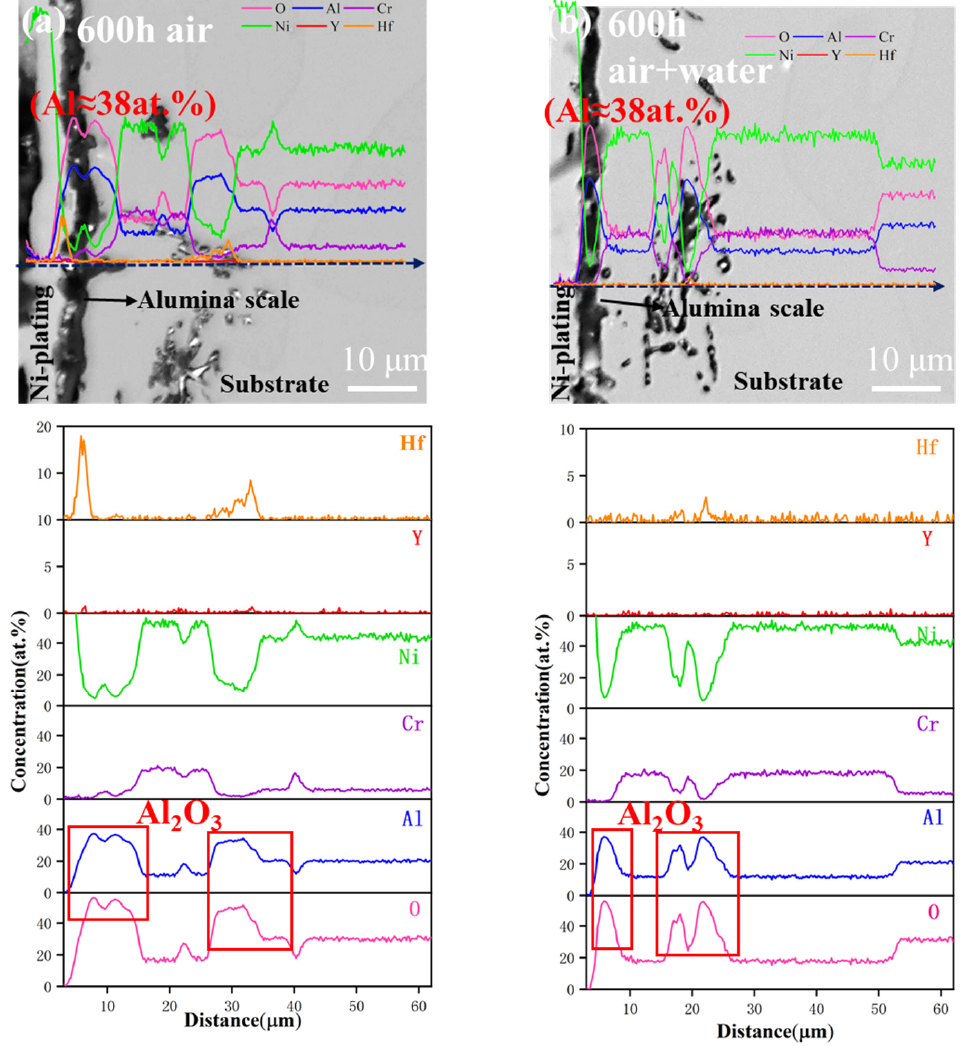
Figure 11. Morphology and EDS results of the NiCrAlYHf alloy oxide scale after 600 h at 1100 °C in air ( a ) and air–water vapor ( b ).